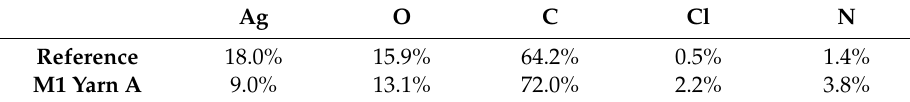
Figure 8. XPS spectrum of the chlorine detected on the electrode M1 yarn A. Table 3. Surface composition of M1 Yarn A.